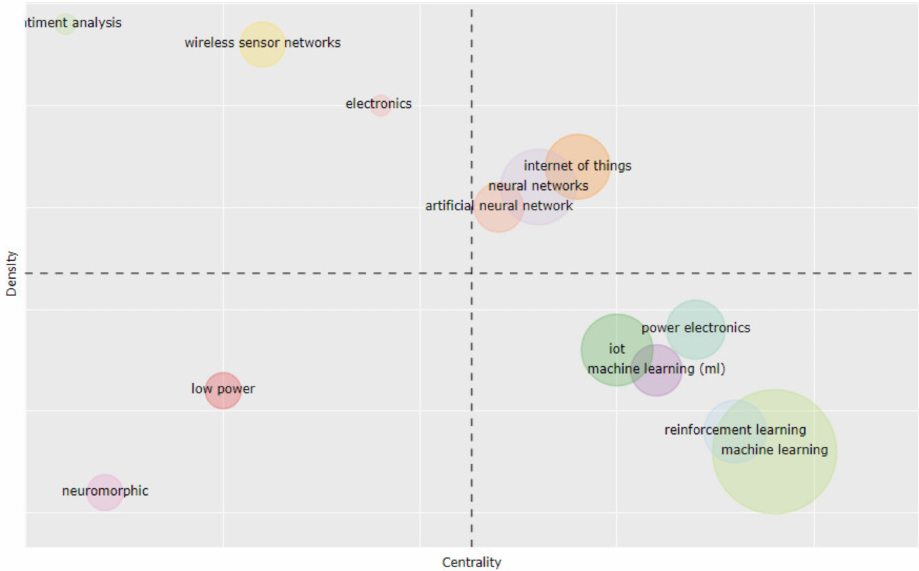
Figure 11. Thematic map, time slice